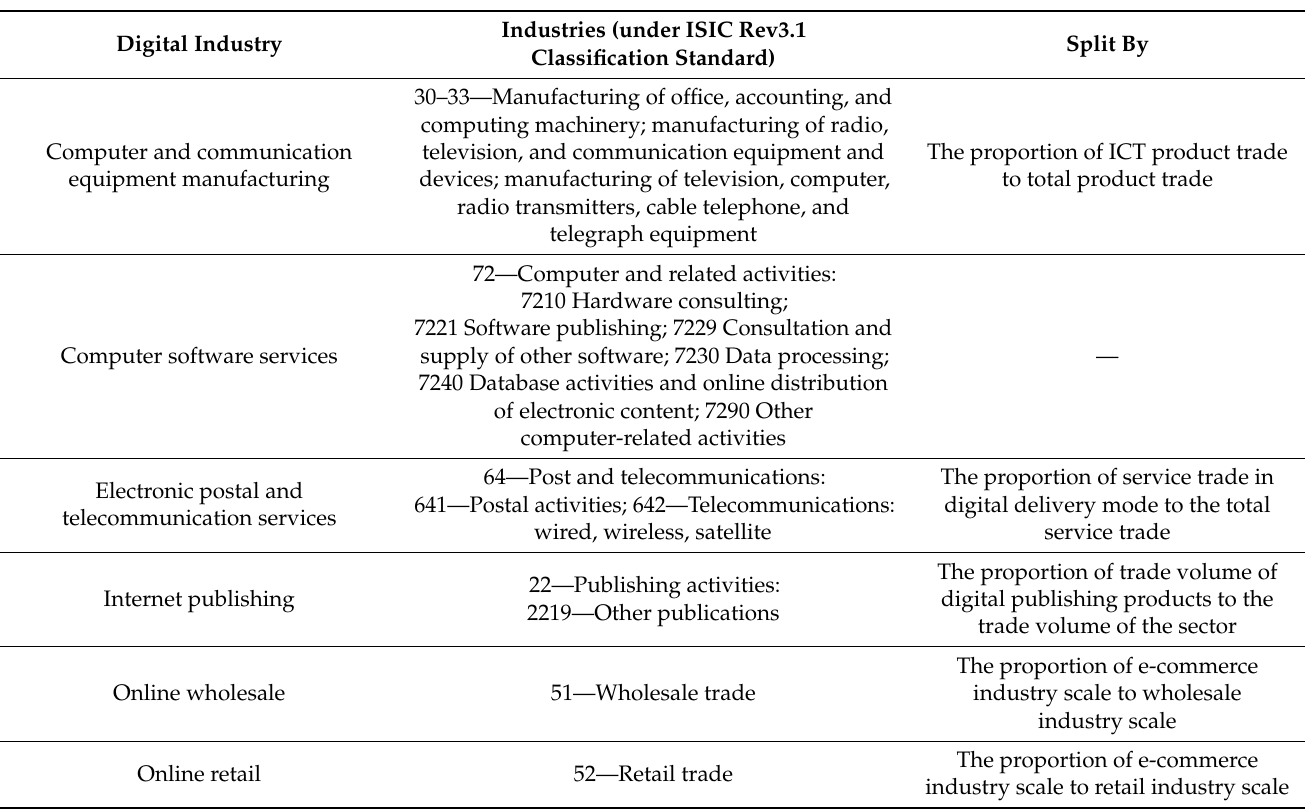
Table 1. Division of digital